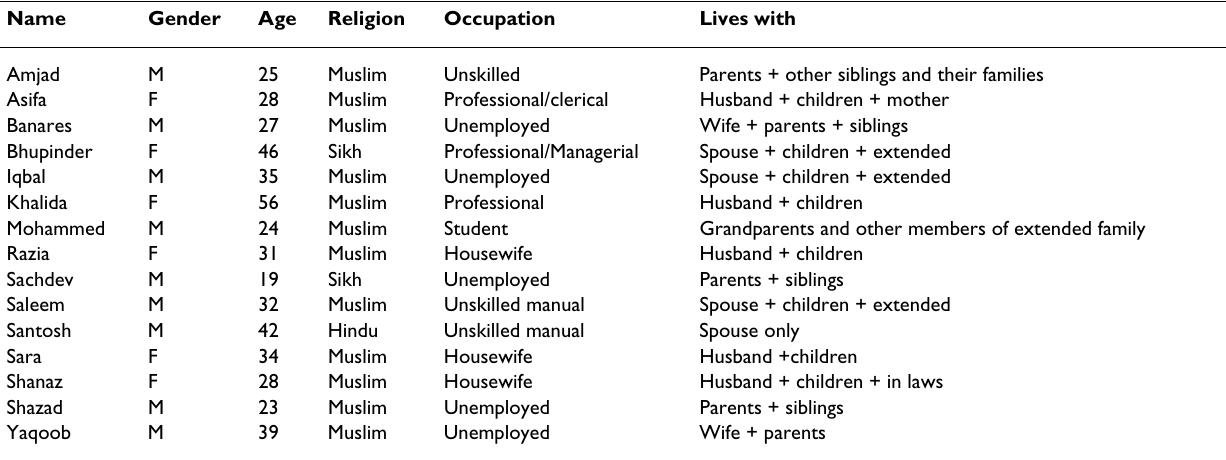
Table 5: Characteristics of those